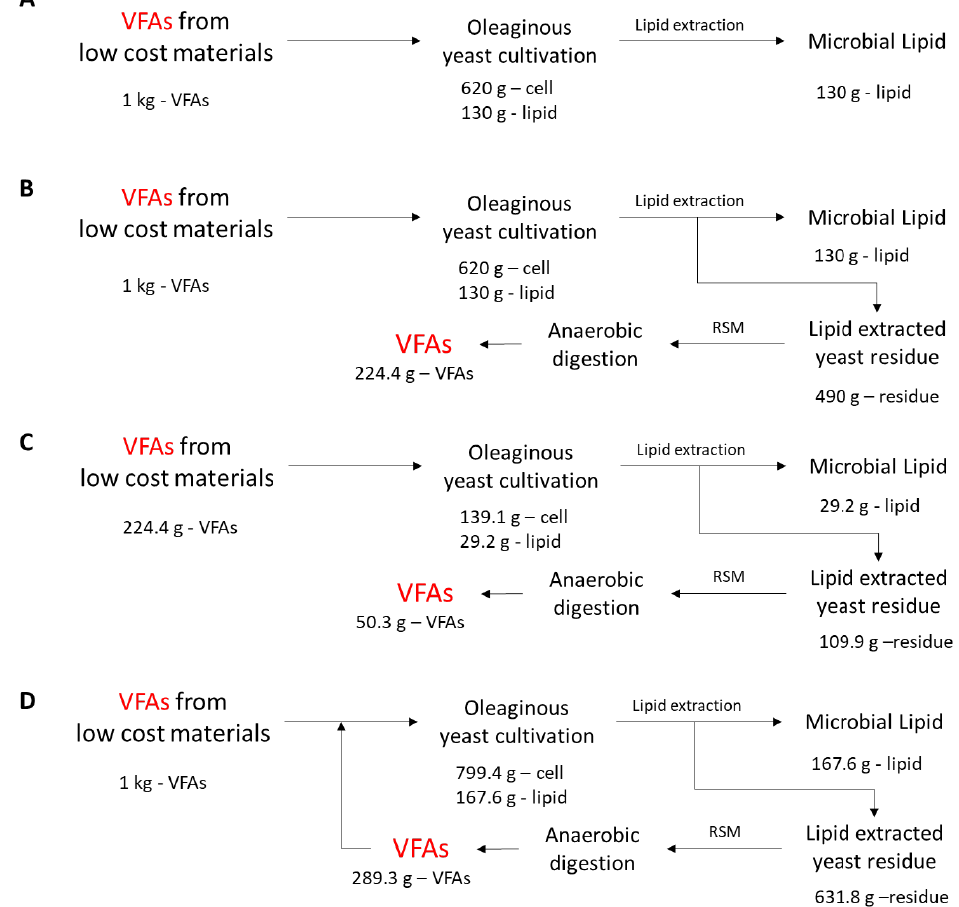
Figure 3. Mass balance of microbial lipid production from volatile fatty acids (VFAs) as low-cost materials and recycling of lipid-extracted yeast (LEY) residues. ( A ) Microbial lipid production from VFAs. ( B ) Microbial lipid production from VFAs and VFA production from the LEY residue. ( C ) Microbial lipid production from VFAs and additional VFAs by the one-time recycling of the LEY residue. ( D ) Microbial lipid production from VFAs and additional VFAs by the unlimited recycling of LEY residues.